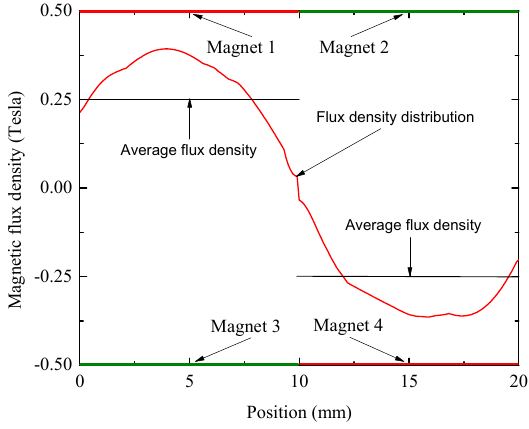
Figure 3. The distribution of the magnetic flux density.